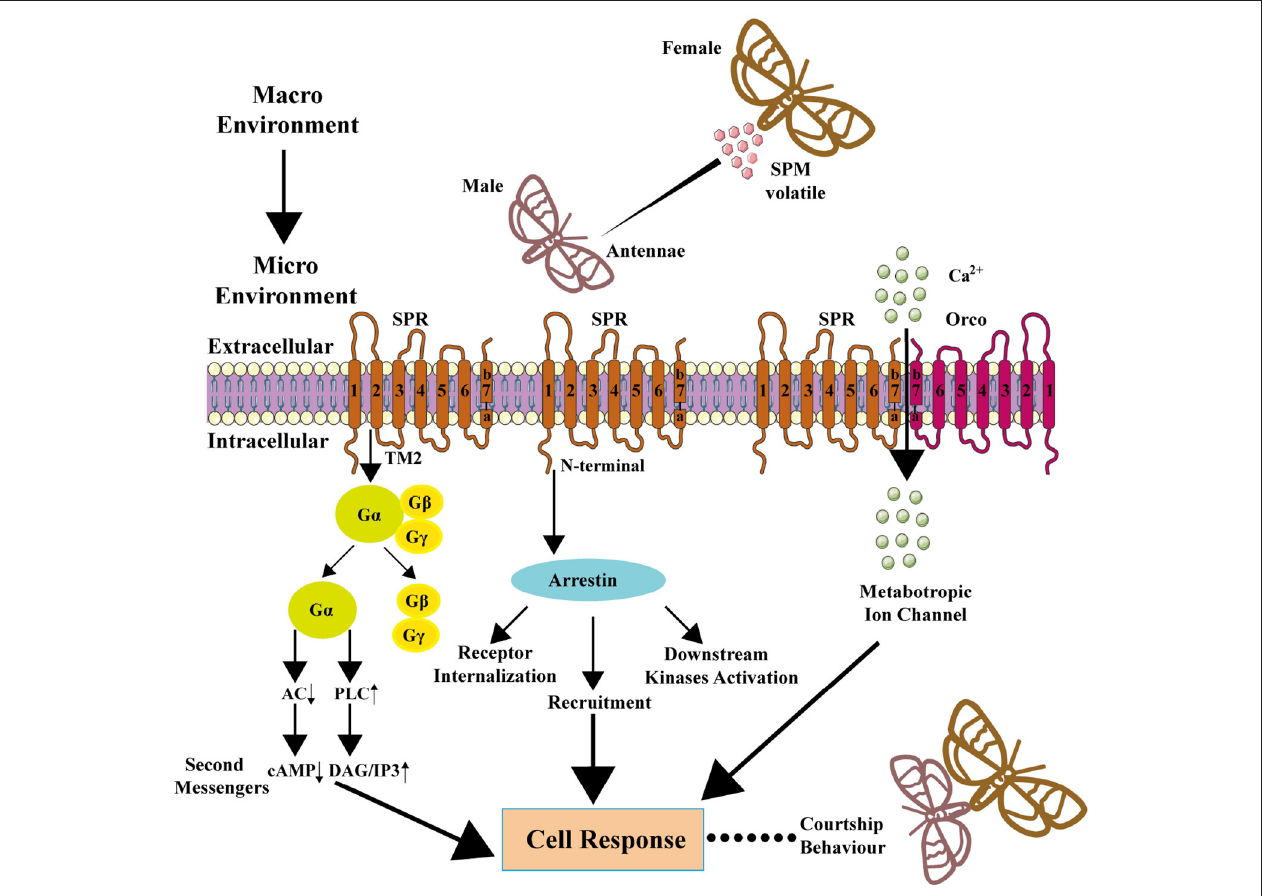
FIGURE 4 | Downstream signaling pathway of SPR and metabotropic channel of SPR-Orco. In macro environment, male insects sense the SPM released by female insects through an olfactory sensory neuron in antennae, and SPM works as an agonist to SPR, and signal transduction leads to ultimate mating behavior.